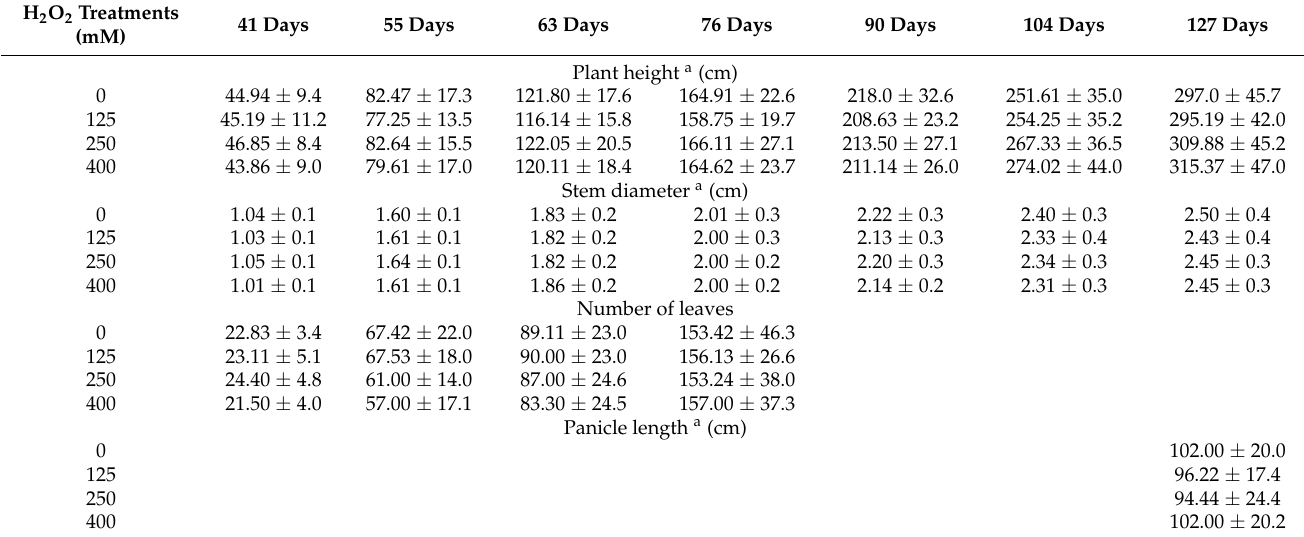
Table 2. Results of the growth parameters of amaranth ( Amaranthus hypochondriacus